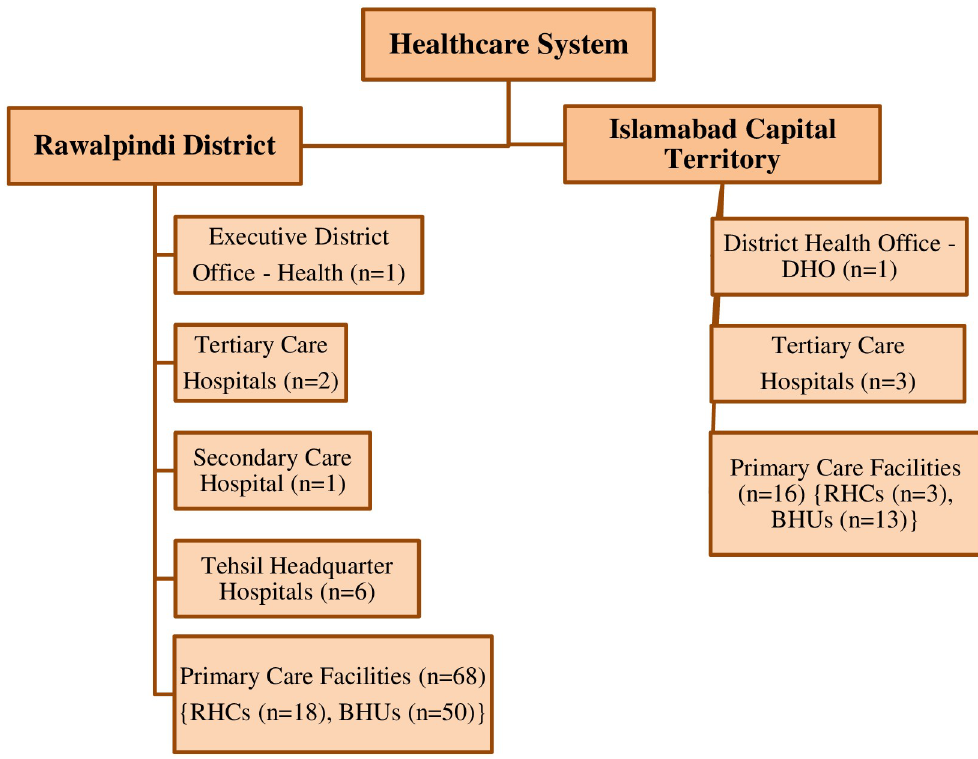
Fig 2. Sampling procedure and sample size. Out of a total of 97 healthcare facilities in both cities, 55 operational healthcare facilities were included in this study. Out of these 55 healthcare facilities, 10 were located in Islamabad while 45 were situated in Rawalpindi district. The healthcare facilities included in this study from different healthcare levels were: Tertiary healthcare (n = 5), secondary healthcare (n = 7) and primary healthcare (n = 41).